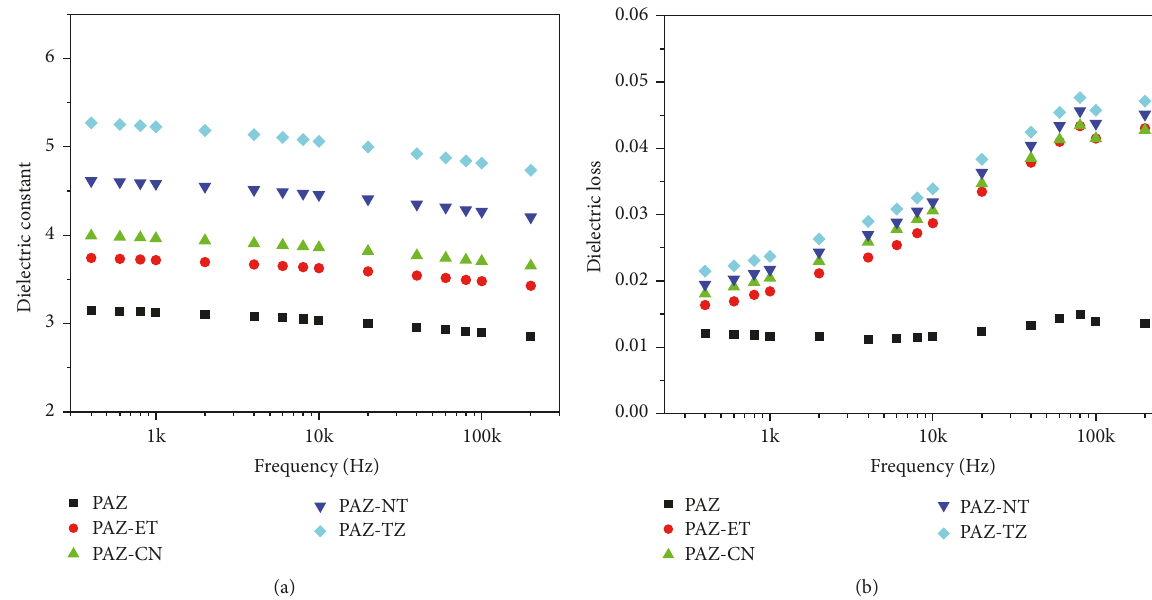
Figure 5: Dielectric constant (a) and dielectric loss (b) of the precursor and the azo